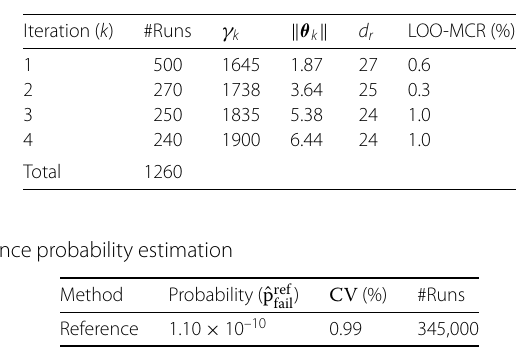
Table 2 VCO: HISMC exploration phase